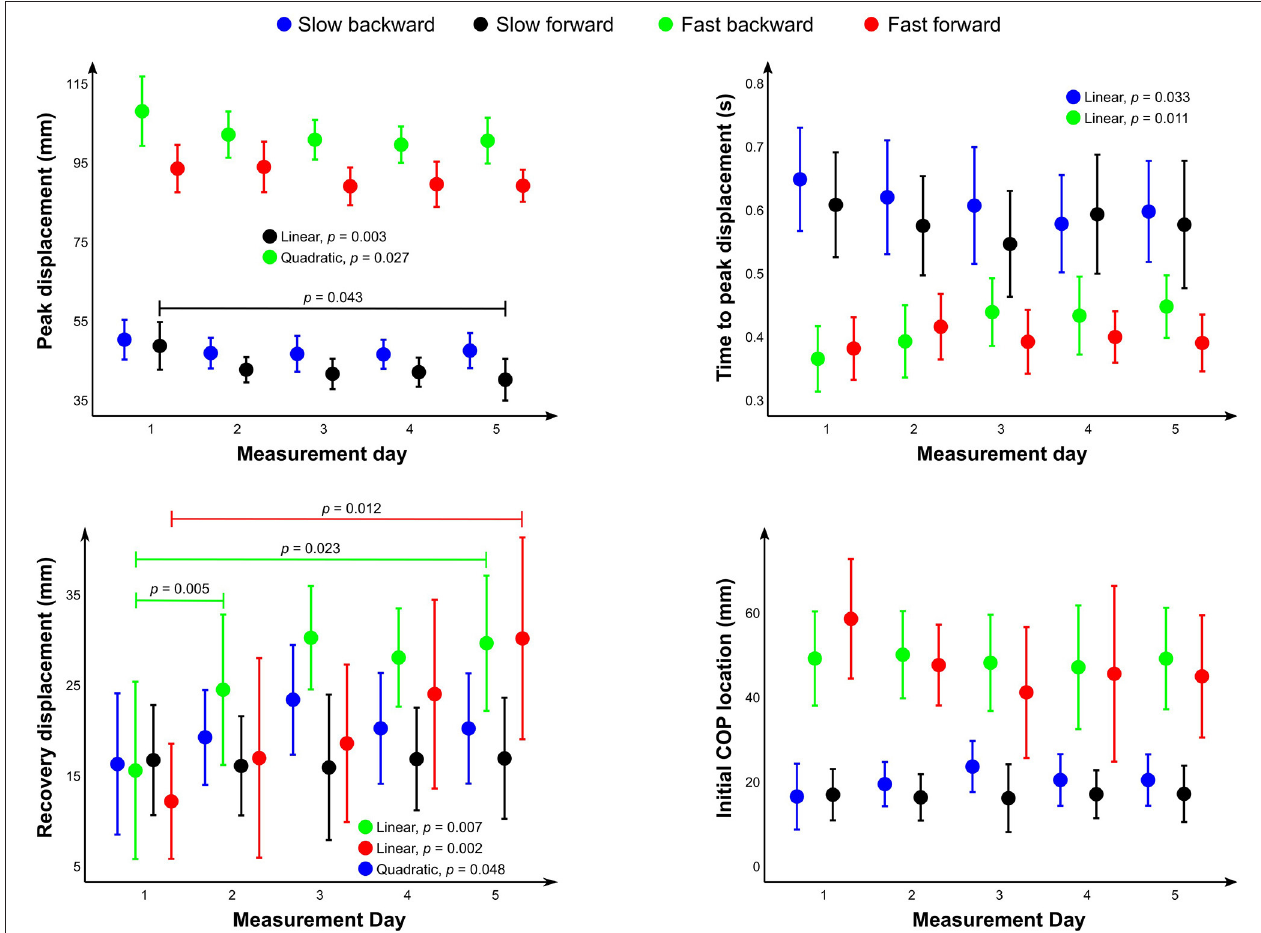
FIGURE 5 | Mean values of the different outcome measures and center of pressure location at the instance of perturbation onset relative to the ankle joint. Whiskers represent the 95% confidence interval of the mean. Statistically significant differences between days and statistically significant linear or quadratic trends across the days are